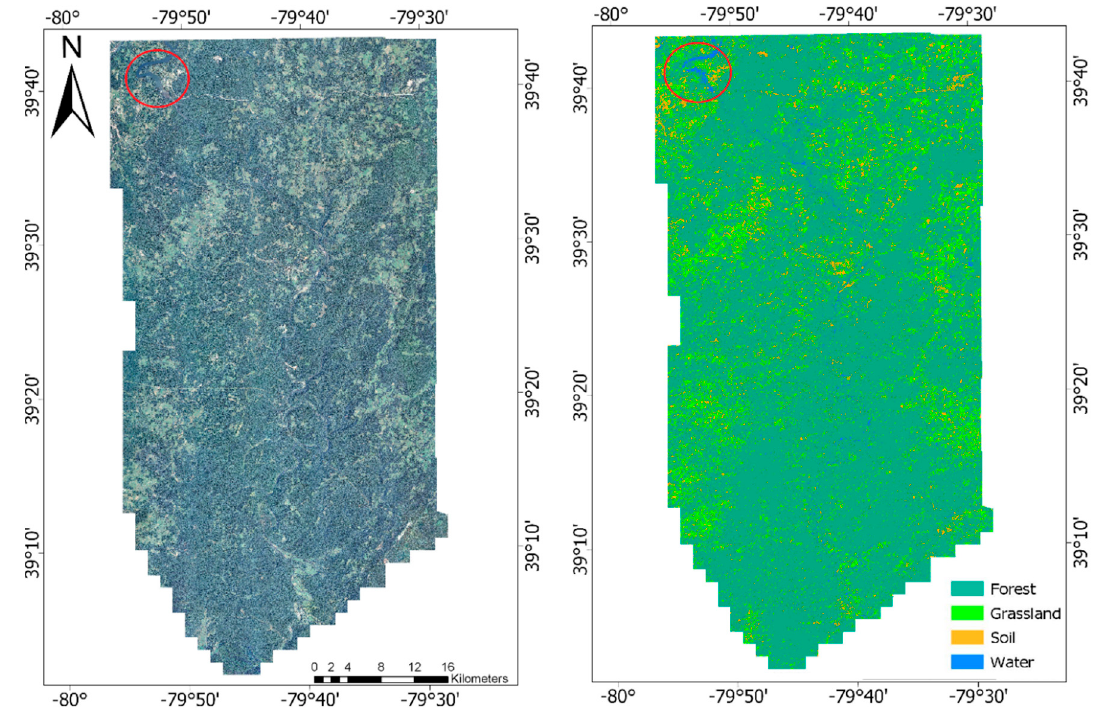
Figure 7. Example land-cover classification of entire study area. Classification produced from the RF classification trained from 10,000 samples with an overall accuracy of 99.8%. The red circle indicates the location of the large lake which was associated with notable classification error displayed in Figure 6.